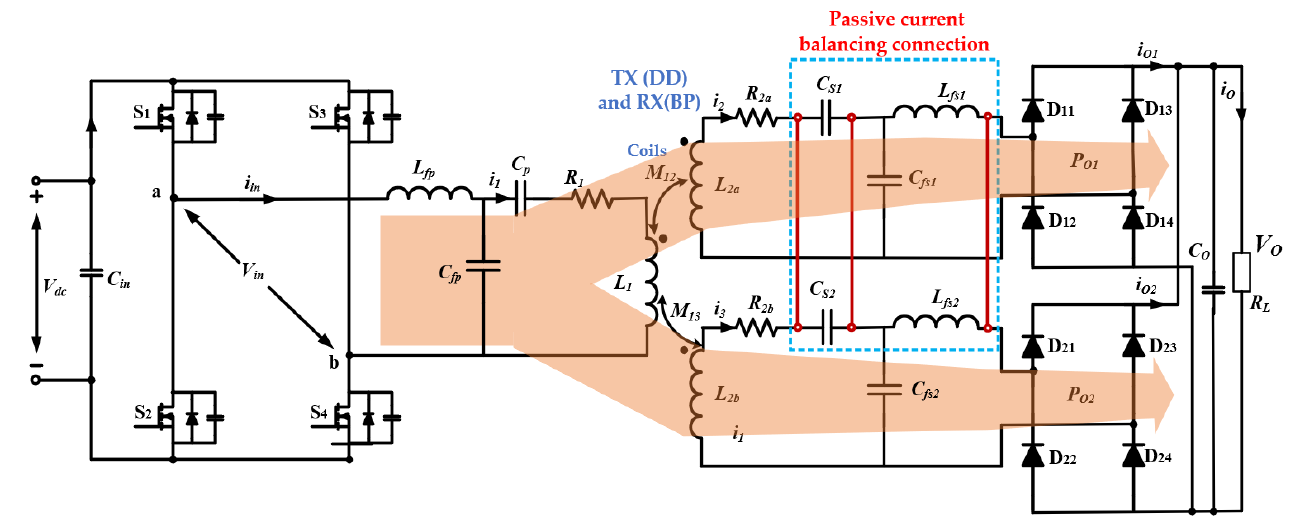
Figure 22. Proposed IPT system for LEV applications.